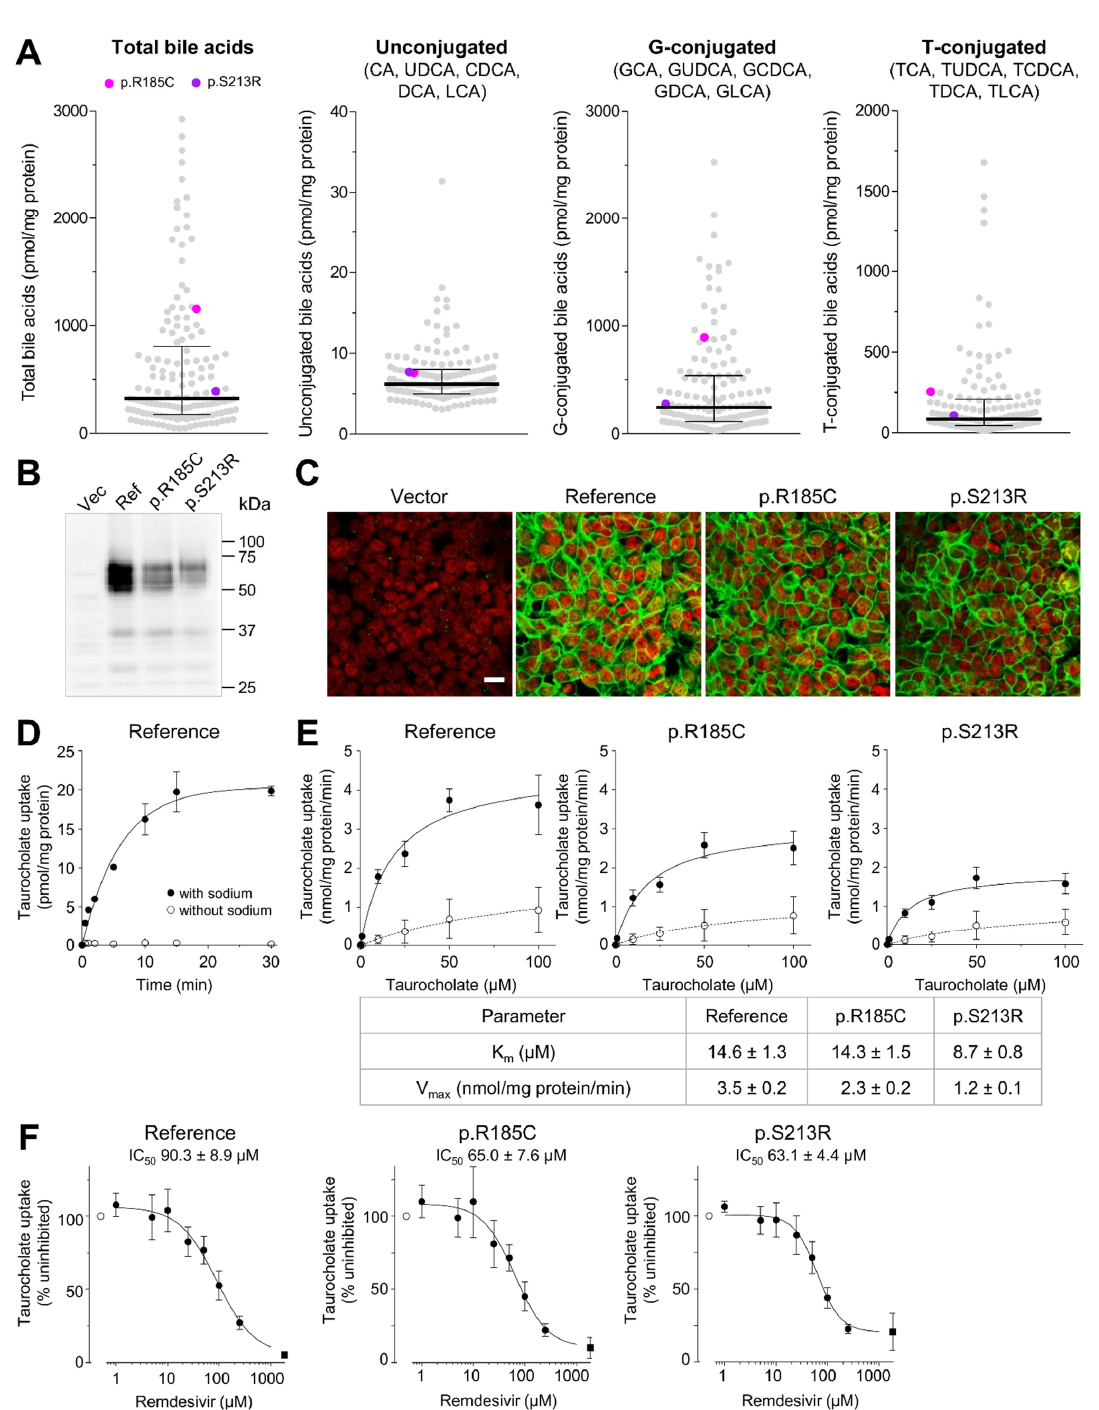
Figure 3. Functional characterization of NTCP missense variants in human liver and cell lines. ( A ) Box scatter plots show bile acid concentrations measured in liver cytosol using Q-TOF LC/MS. Individual levels are shown using gray colored circles. Heterozygous carriers of the two missense variants